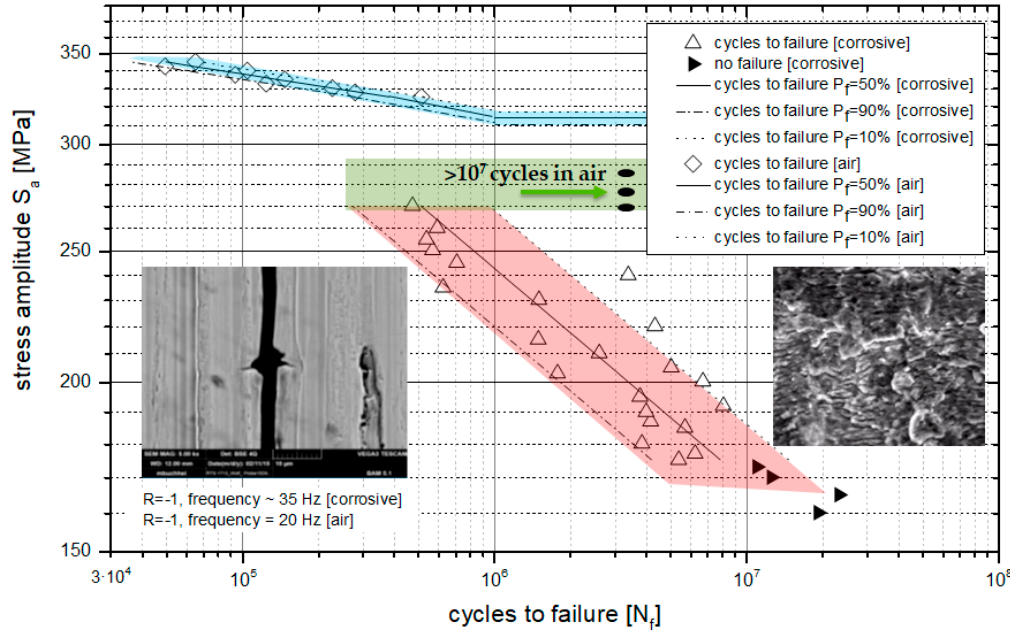
Figure 12. S-N curve of X46Cr13 at R = − 1, frequency 30 Hz: Corrosion fatigue compared to the endurance limit in air, fatigue crack, pits, and striations on the fatigue fracture surface.